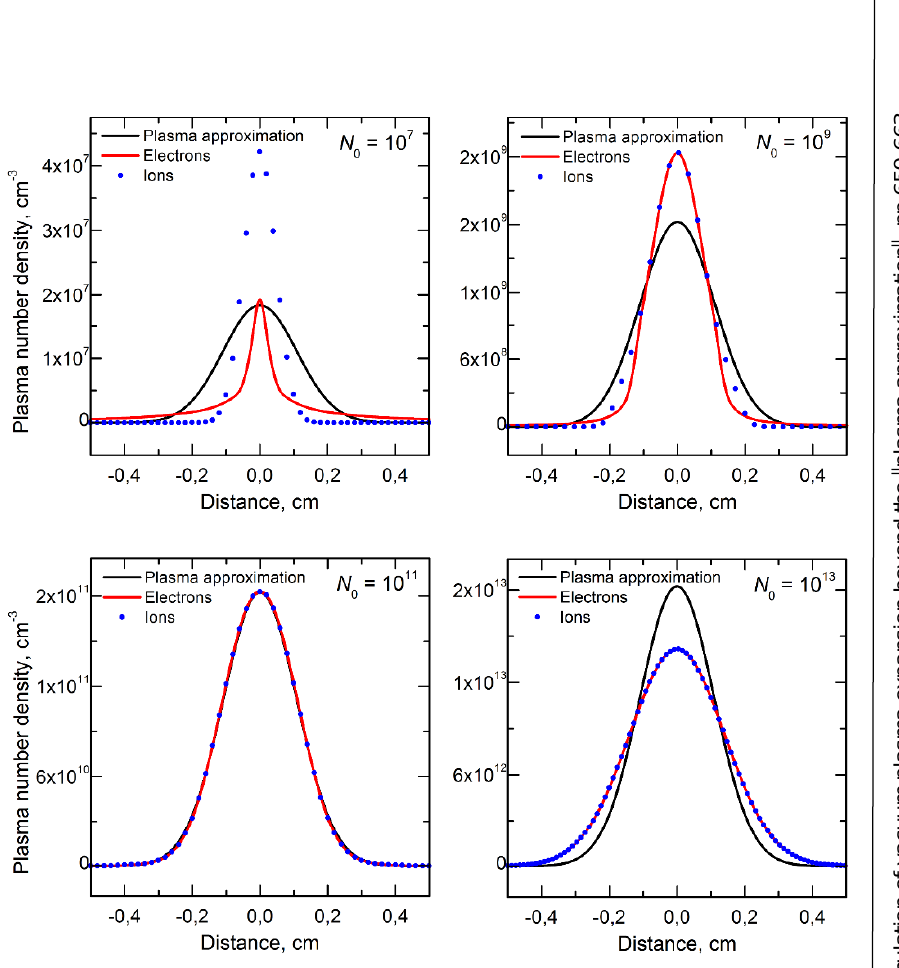
Figure 1 – Comparative plasma number density distributions obtained from numerical calculations without the "plasma approximation" (red line and blue points) and from exact analytical formulas in the "plasma approximation" (black